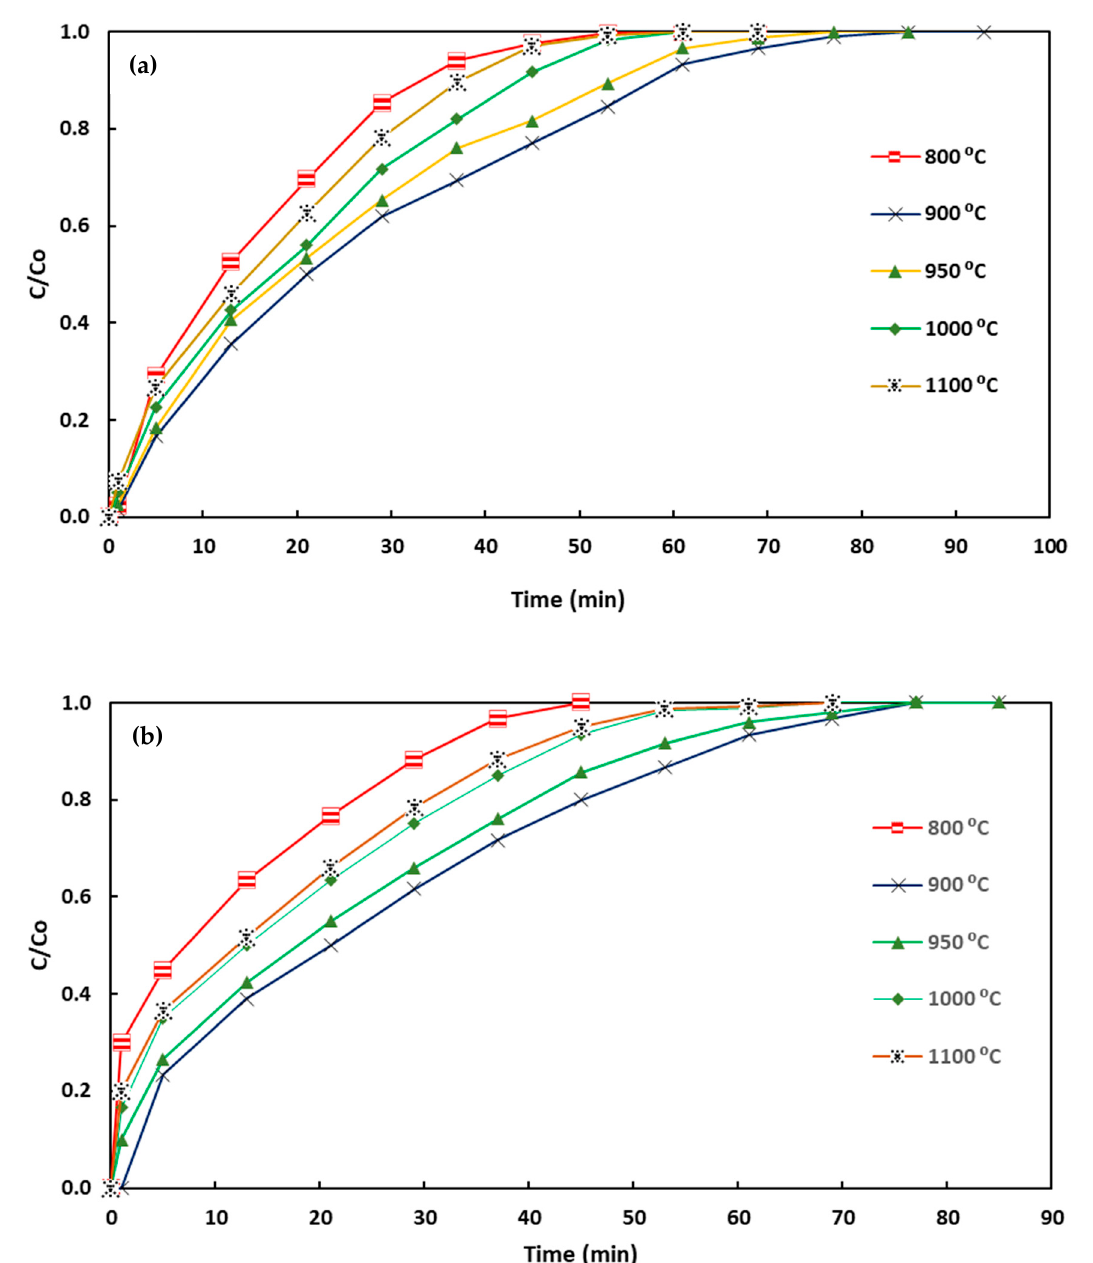
Figure 6. Adsorption breakthrough curves of ( a ) SO 2 and ( b ) H 2 S by eggshell at different calcination.